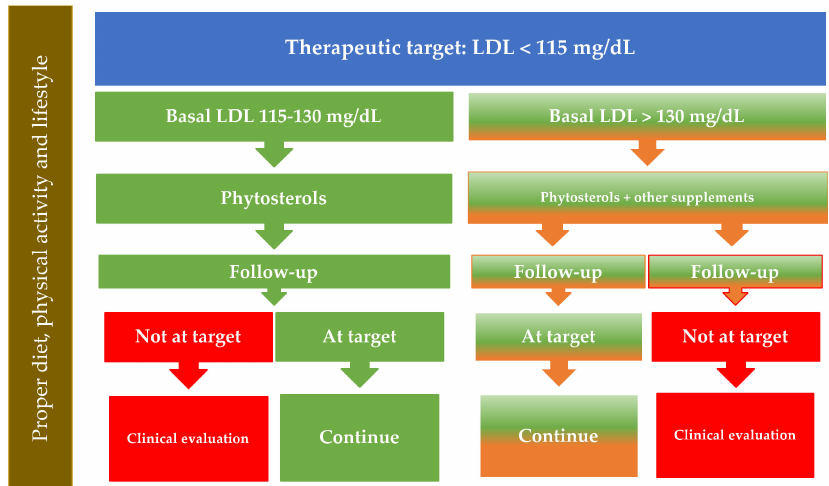
Figure 2. Flowchart A. Patient <40 years old or >40 years old, but with global cardiovascular risk <1%. This flow-chart is not appropriate for patients with genetic disorders of lipoprotein metabolism or with manifest cardiovascular disease, who need to be treated according to the Guidelines.